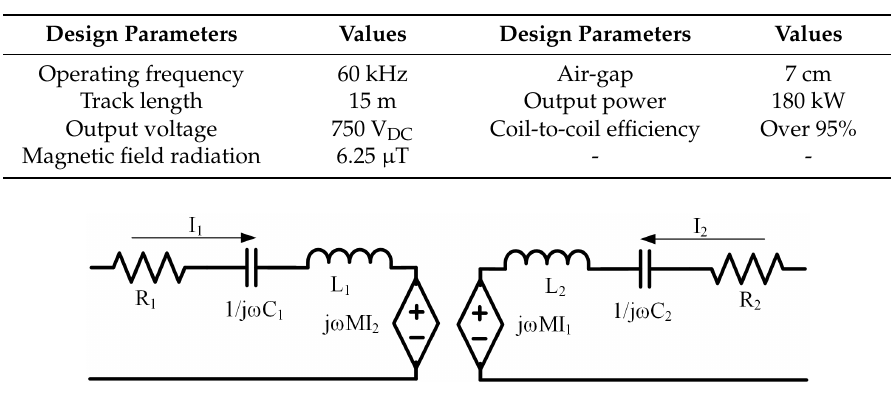
Figure 2. An equivalent circuit of a series-series tuned Wireless power transfer (WPT) system.